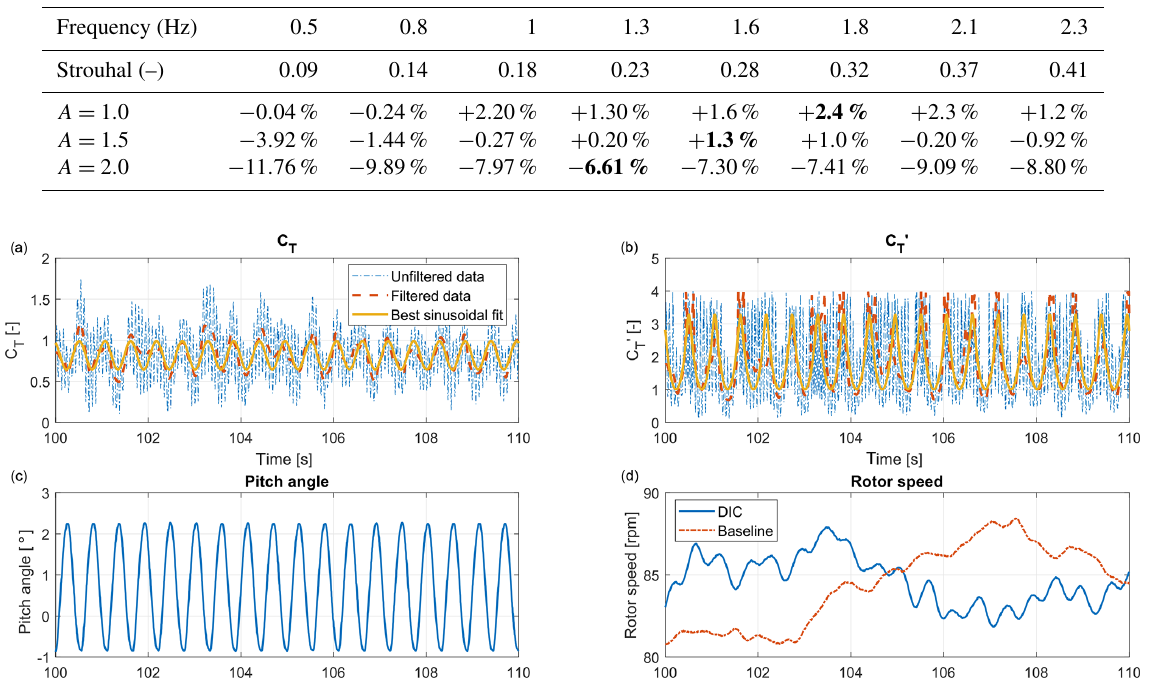
Figure 12. A box plot showing the variance of the C P measurements for the low-turbulence, C (cid:48) as well as for the entire wind farm. The f = 0 measurement represents the baseline case of no dynamic